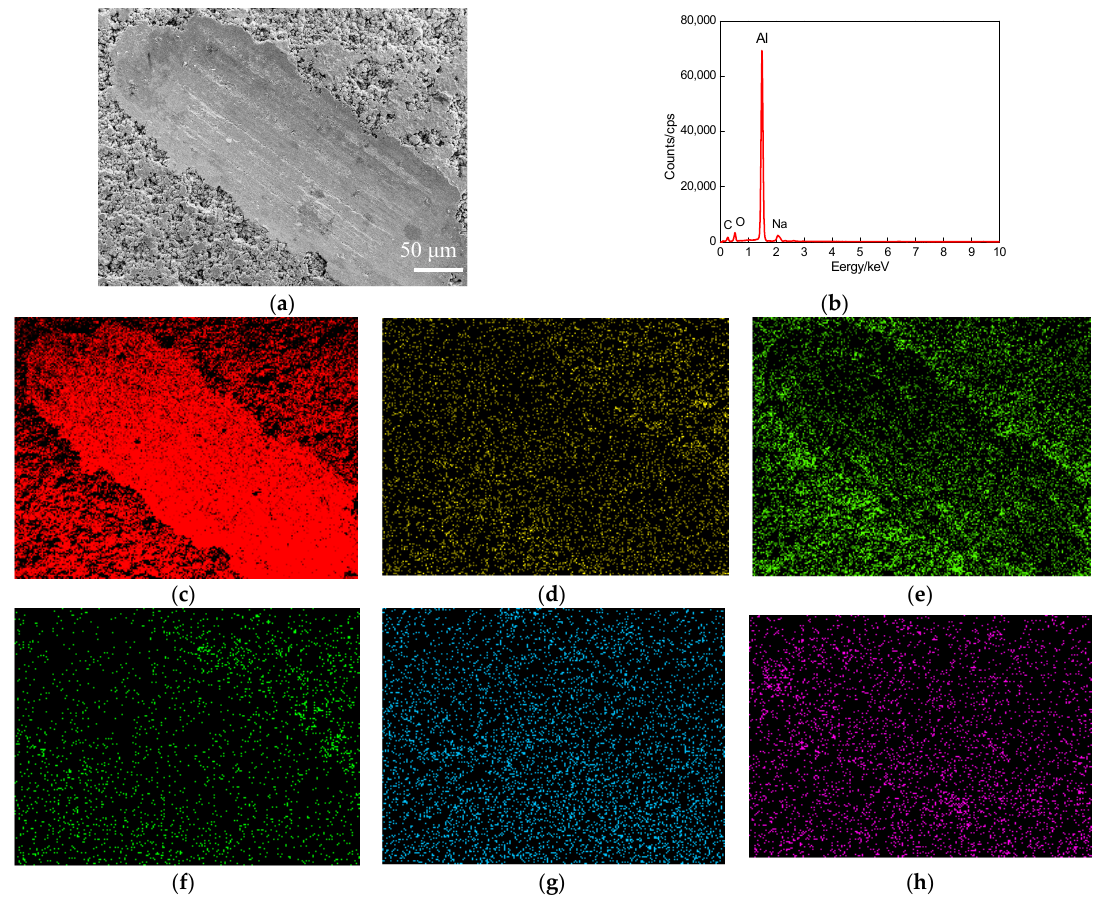
Figure 7. Plane scan analysis of worn track at wear speed of 400 times/min (wear load of 1 N). ( a ) Plane scanned position; ( b ) Result of plane scan analysis; ( c ) Al content; ( d ) C content; ( e ) O content; ( f ) Fe content; ( g ) Na content; ( h ) Cl content.